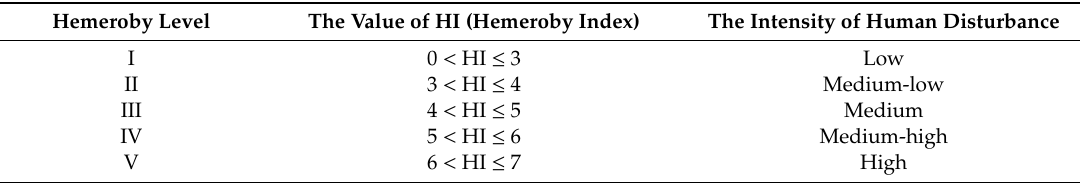
Table 4. Level of the intensity of human